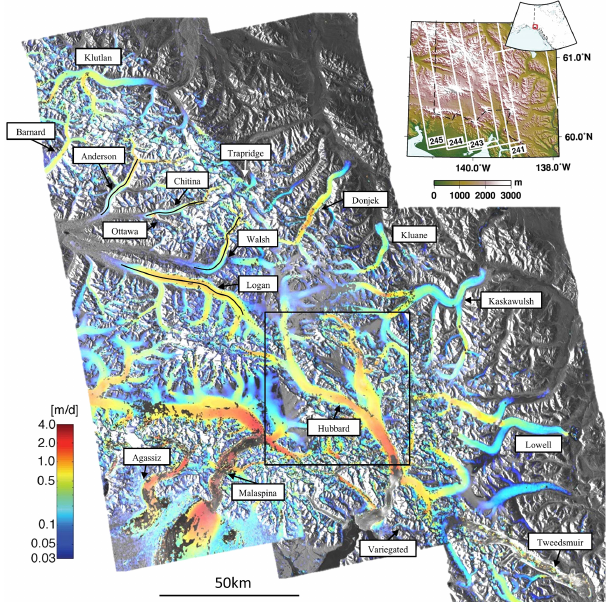
Figure 1. Composite ice-speed map of the study area. The indi- vidual maps for the study area were derived by intensity tracking between two PALSAR images. The left, middle and right velocity maps are derived from images pairs from 10 February 2010 and 28 March 2010 of Path 245, 30 December 2006 and 14 Febru- ary 2007 of Path 243, 14 January 2008 and 29 February 2008 of Path 241, respectively. The square region around Hubbard Glacier is shown in Fig. 4. Black lines in some glaciers show the flow line. The upper right panel indicates the location and topography of the study area as well as the satellite’s imaging